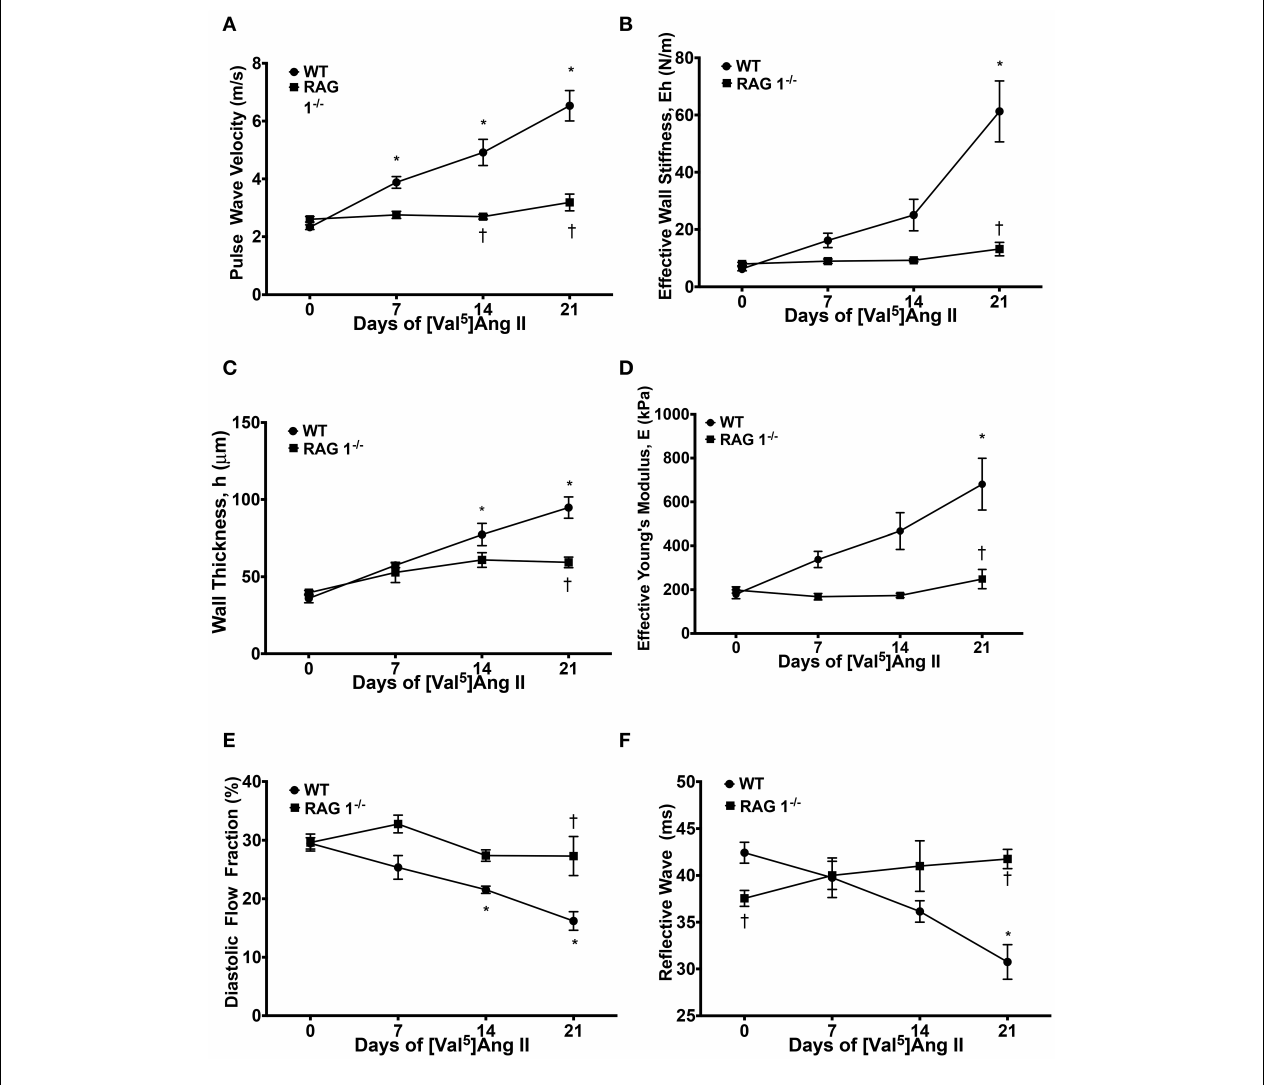
diastolic percentage of the velocity-time-integral (VTI) in the aortic Doppler flow wave. (F) Reflective wave represents the transit time of the intersection of the forward and reflective flow waves from the R wave of the EKG. * P < 0 . 05 to day 0 WT; † P < 0 . 05 to WT at respective time point. N = 4 –22. Data are means ±